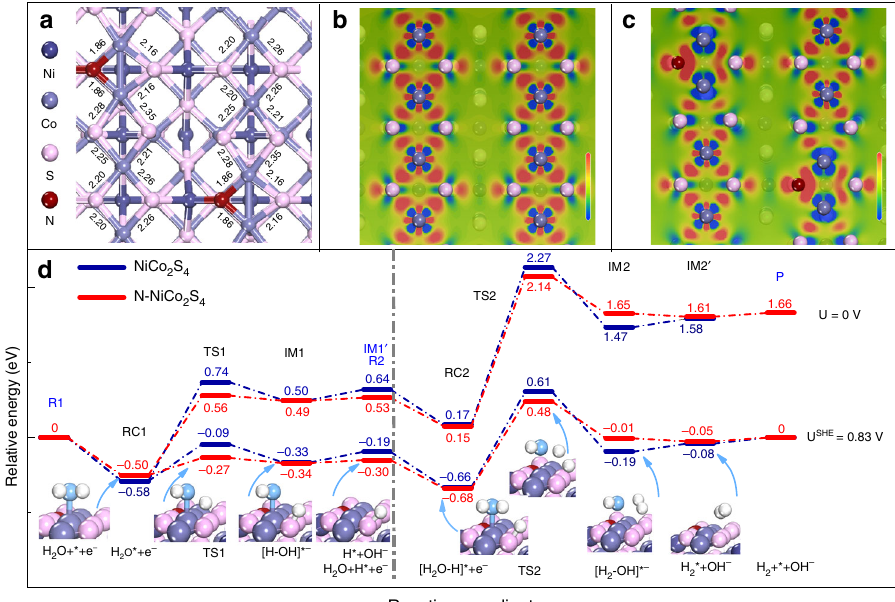
Fig. 5 DFT calculations of NiCo 2 S 4 and N-NiCo 2 S 4 . a The top-view structures of N-NiCo 2 S 4 (100) with labeled bond lengths (Å) of Co – S and Co – N bonds. The top-view electron density difference of b NiCo 2 S 4 (100), and c N – NiCo 2 S 4 (100), ranging from − 0.1 to 0.1. d Relative energy pro fi les and the simpli fi ed surface structures of the various reaction species along the reaction pathway, including the H* formation process (left panel) and H 2 formation process (right panel) in alkaline on the NiCo 2 S 4 (100) and N – NiCo 2 S 4 (100) at electrode potential U = 0 V and U SHE = 0.83 V, respectively. R Reactant, RC Reactant Complex, TS Transition State, IM Intermediate, P